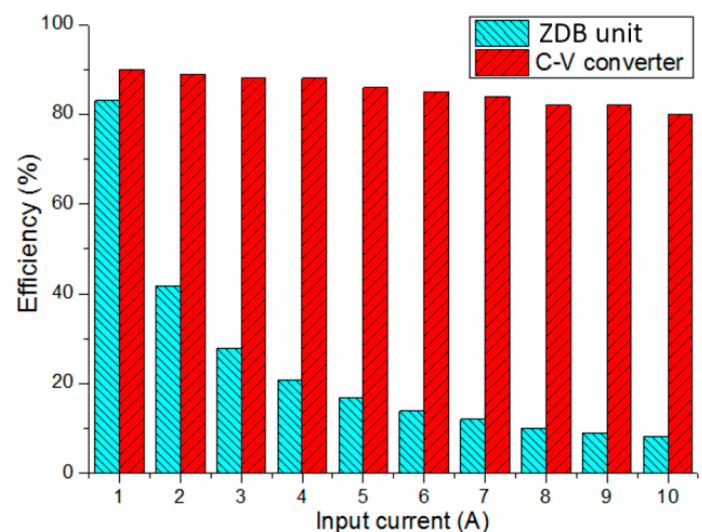
Figure 13. Comparison on the efficiency of the zener-diodes-based module and the prototype under different input direct current (DC) line currents.